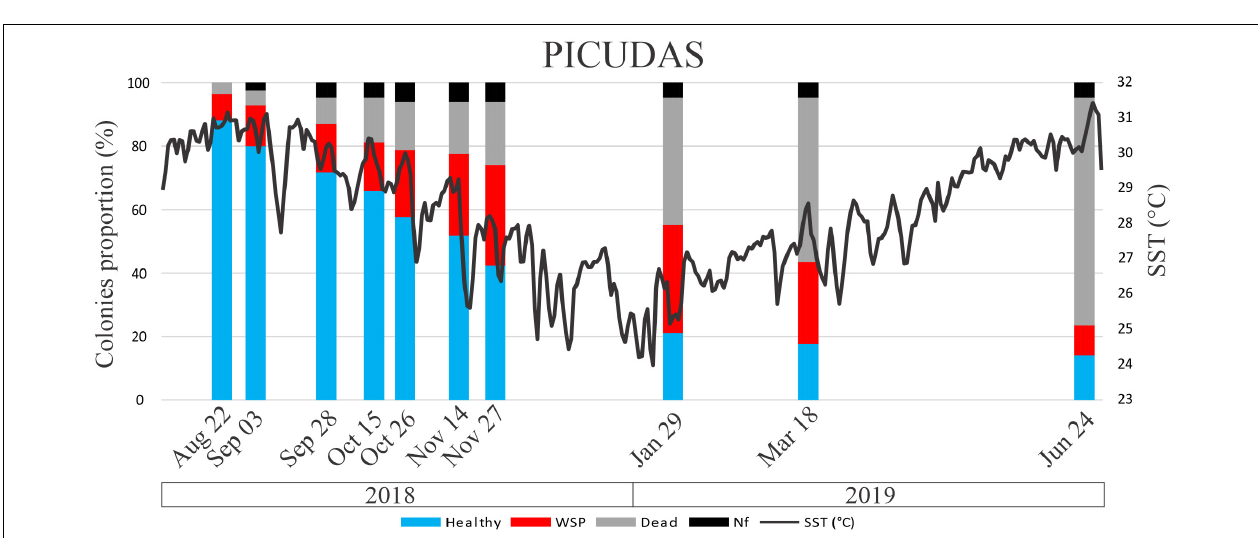
FIGURE 5 | Percentage of colony condition status through time of P. strigosa colonies at Picudas site. Nf is missing colonies. A continuous dark line indicates daily mean sea surface temperature (SST, ◦ C) at Puerto Morelos